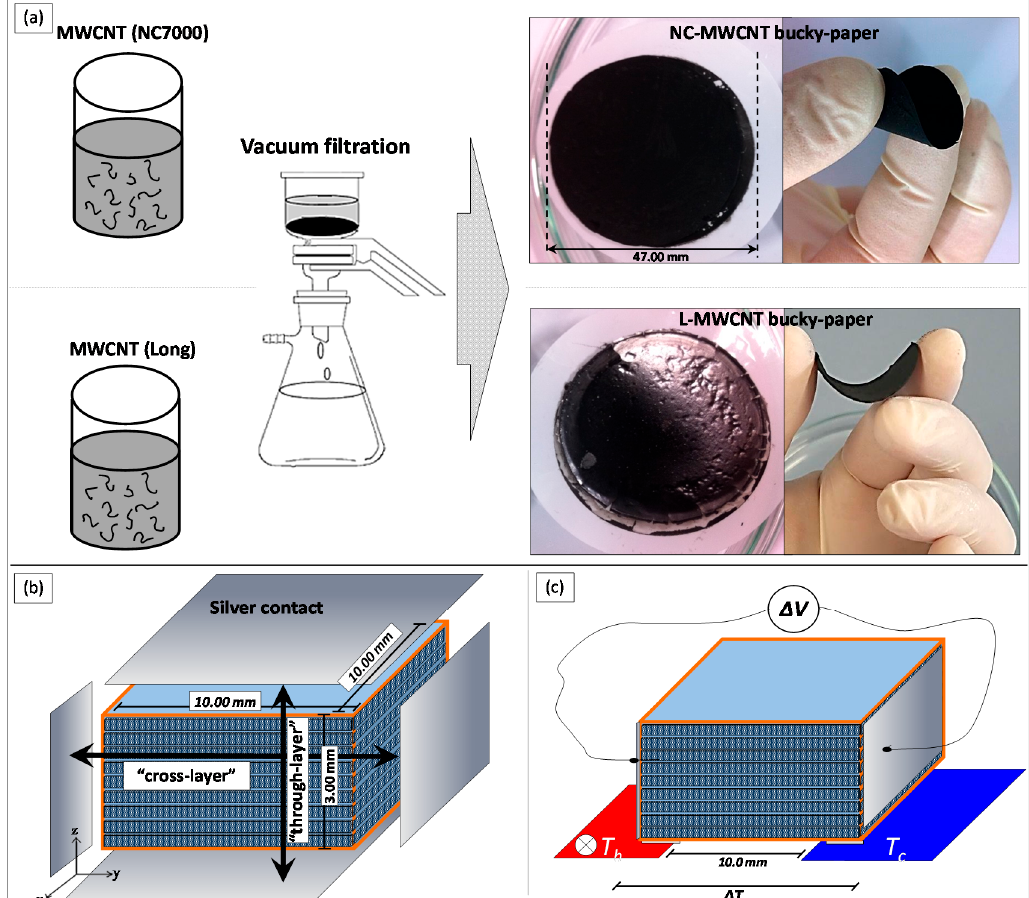
Figure 1. ( a ) Vacuum filtration process to fabricate MWCNT bucky paper films. ( b ) Schematic illustration of the cross- and through-layer electrical conductivity measurements for the different TPU/MWCNT FDM 3D printed nanocomposites, and ( c ) thermal gradient set-up used for the Seebeck coefficient measurements.